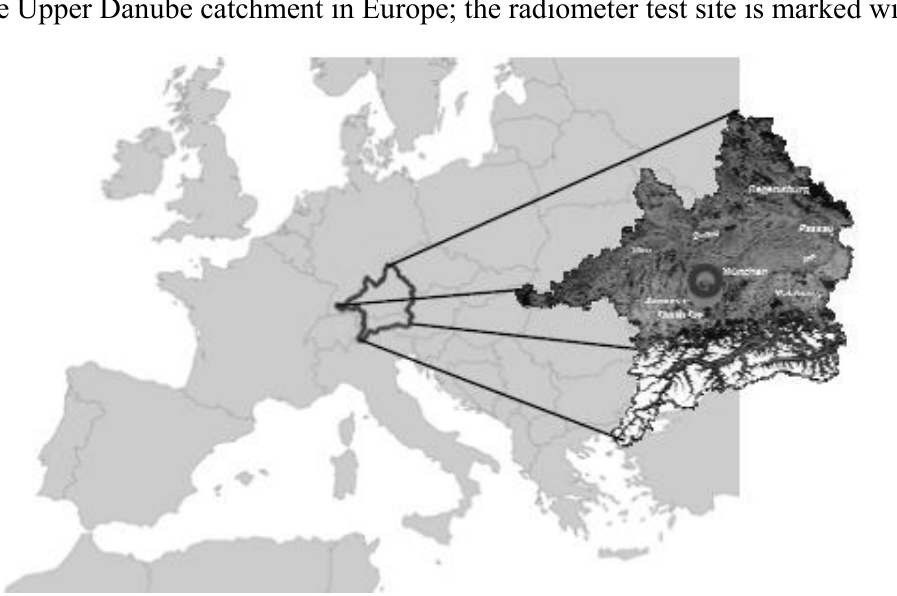
Figure 1. The Upper Danube catchment in Europe; the radiometer test site is marked with a circle.